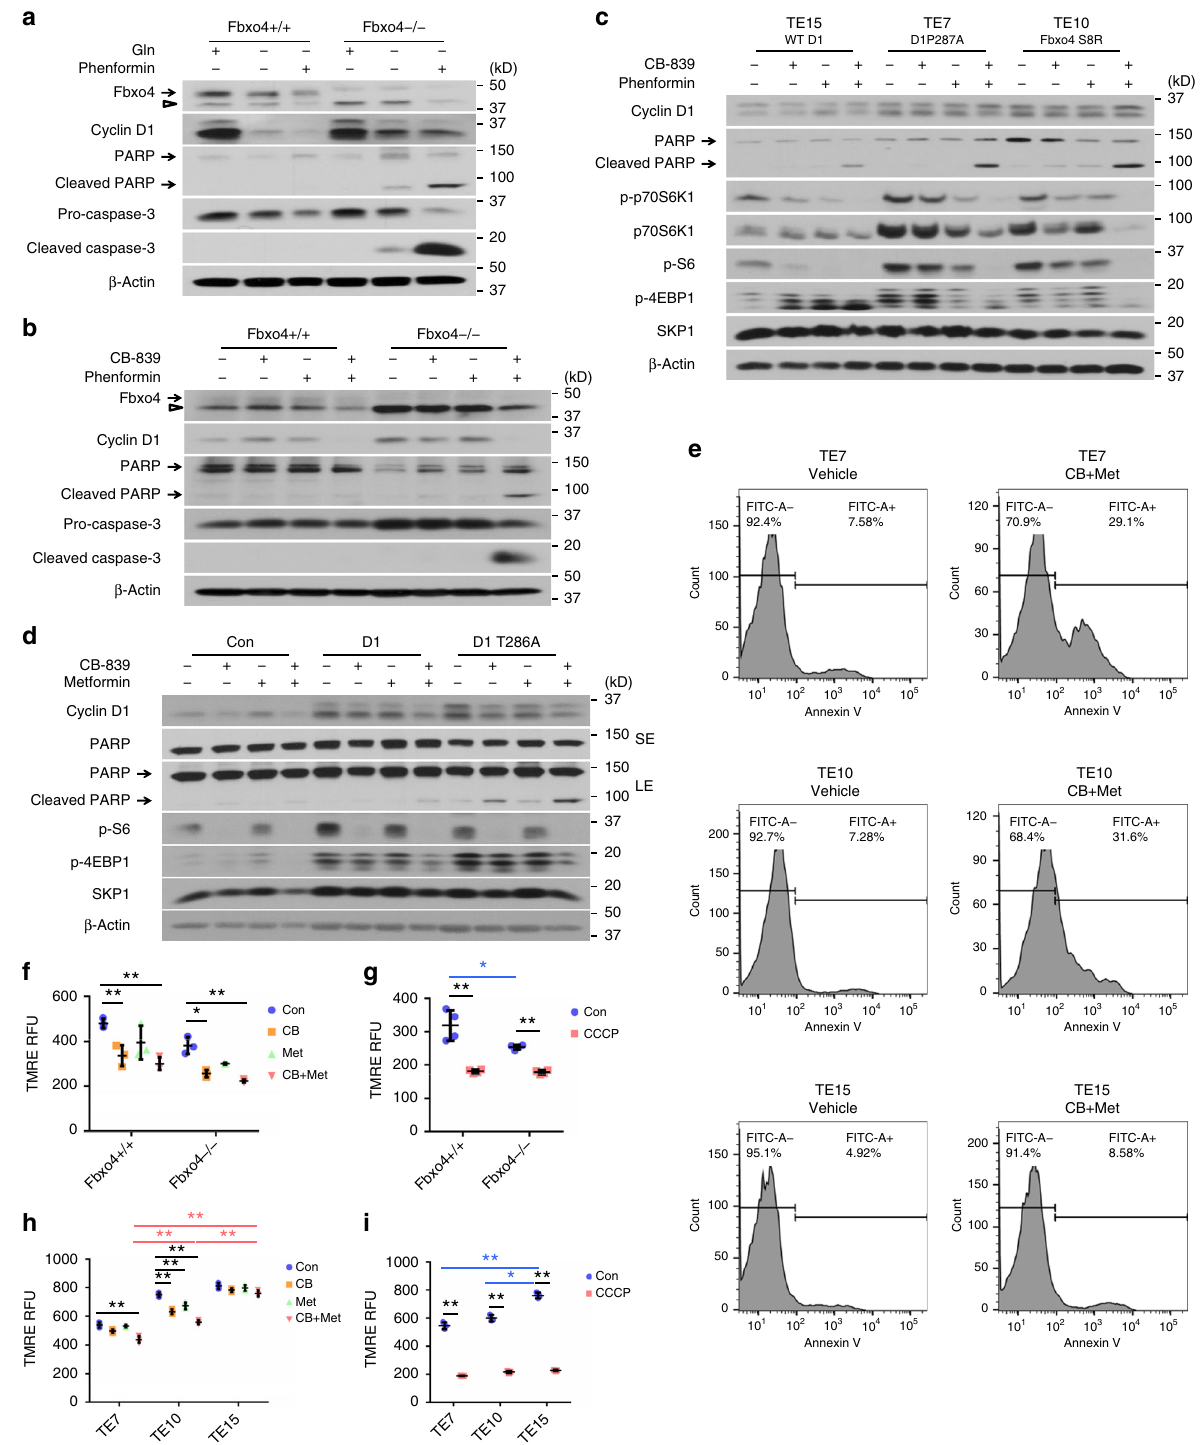
Fig. 5 CB-839 plus Phenformin/Metformin synergistically induces apoptosis. a Western analysis of PARP and caspase-3 cleavage in Fbxo4 − / − versus + / + mouse embryonic fi broblasts (MEFs) treated with Phenformin following 24 h Gln-depletion. b Western analysis for the indicated proteins in Fbxo4 + / + versus − / − MEFs treated with CB-839 plus phenformin for 24h. c Western analysis for PARP cleavage following 24 h treatment with CB-839 and/or phenformin in TE7, TE10, and TE15 cells. d Combined treatment for 24 h induces more apoptosis in TE15 cells with ectopic cyclin D1 or D1T286A expression. SE: short exposure; LE: long exposure. e FACS for Annexin V-positive cells following combined CB-839 (CB) and metformin (Met) treatment for 48 h. f , g Mitochondrial membrane potential analysis of Fbxo4 + / + and − / − MEFs with the indicated treatments; g CCCP treatment as positive control. h , i Mitochondrial membrane potential analysis of TE7, TE10, and TE15 cells with indicated treatments; i CCCP treatment as positive control. All data represent as mean ± s.d., one-way ANOVA was used to compare means with Bonferroni as Post Hoc test ( n = 3). * p < 0.05; ** p < 0.01. CB-839 concentration is 10 μ M and phenformin/metformin concentration is 1 mM for panels a – i . Arrow: speci fi c band; open triangle: non-speci fi c